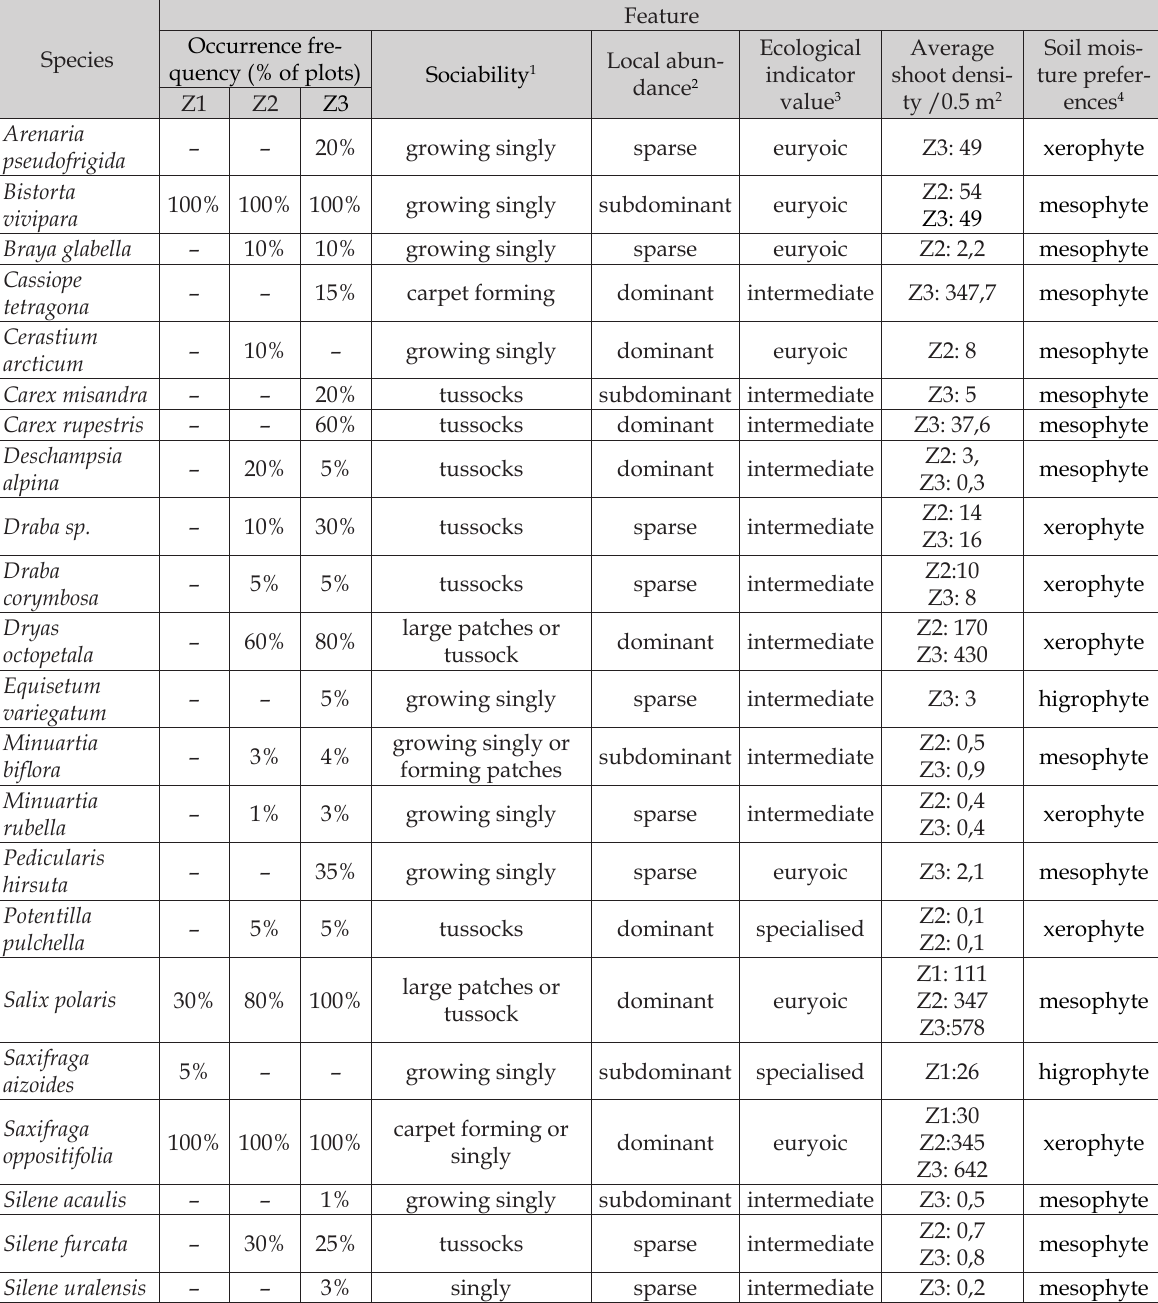
Table 3. Occurrence frequency (% of sample plots), sociability, local abundance, ecological indicator value, average shoot density and phytoecological features of